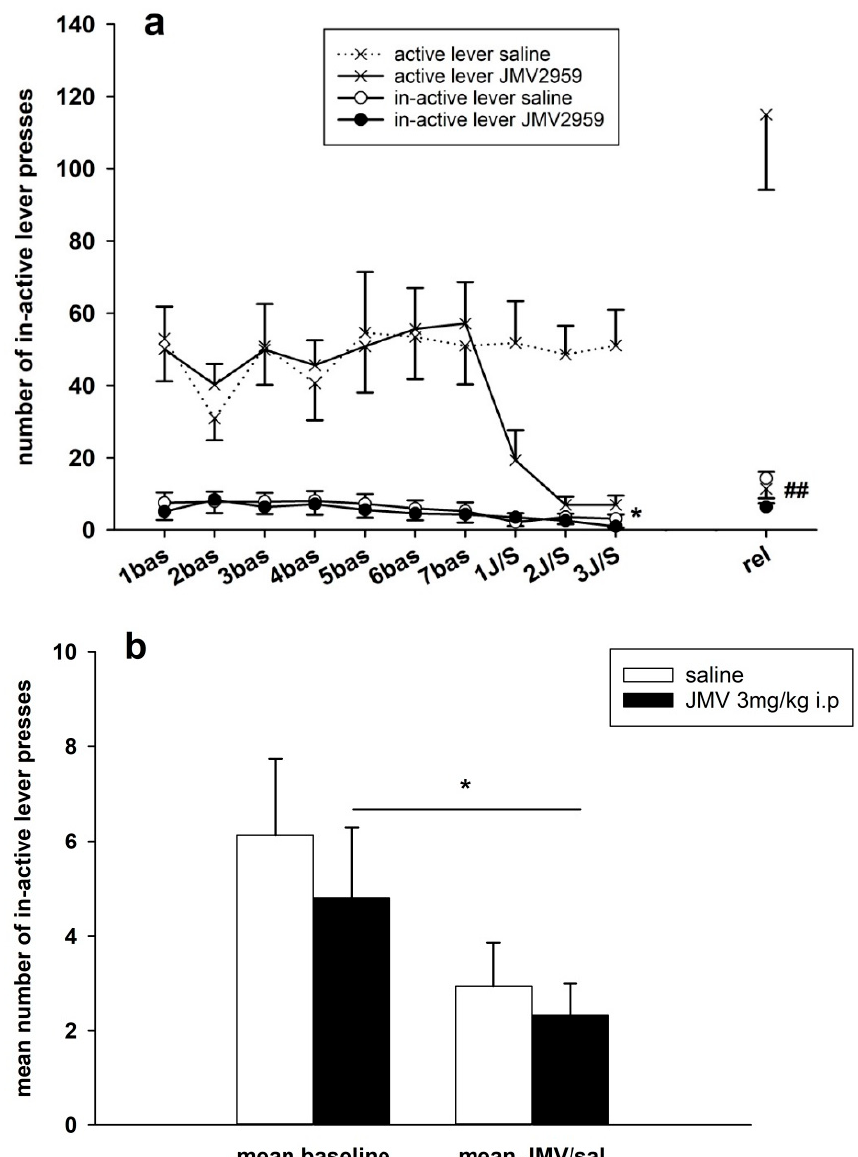
Figure 9. Changes of inactive lever-pressing during the methamphetamine IVSA and JMV2959 pretreatments. JMV2959 3 mg/kg or saline were administered i.p. 20 min before the sessions. In the graph ( a ) inactive lever-pressings within daily 3 h sessions are illustrated during the last week before pretreatments, during the three pretreatment days and during the relapse-like behavior testing on the 12th day of abstinence, when the rats were not connected to the infusion pump. Mean of the last three baselines before the pretreatment (5–7 bas) was used for statistical analysis by two-way ANOVA RM. Means of the rat groups are presented ± SEM; N = 12 (JMV2959 group), N = 8 (saline group). In the graph, ( b ) the mean JMV2959/saline inactive lever-pressing (1–3 JMV/sal) are illustrated together with the mean baselines (5–7 bas); two-way ANOVA was used for analysis. The effects are showed as follows: saline (open circle, open bar), JMV2959 (filled circle, filled bar). Differences between groups are expressed as ## p < 0.01. Differences to baseline mean are expressed as * p < 0.05, the horizontal arrow shows the two appropriate